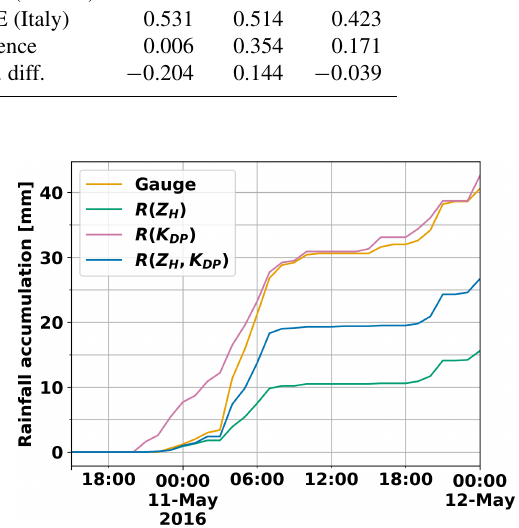
Figure 4. The 1h rainfall cumulative accumulations from Verolengo gauge, located 29km from the radar, and co-located Bric della Croce radar QPE. Z H is not corrected for